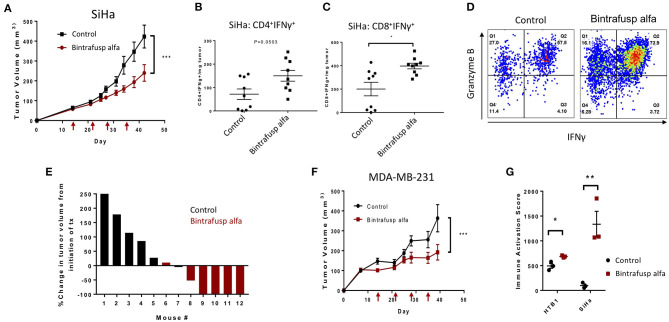
Bintrafusp alfa confers a robust anti-tumor effect in the HPV+ SiHa cervical and MDA-MB-231 triple negative breast cancer models. (A) Average SiHa tumor volumes from control (black) or bintrafusp alfa-treated (red) PBMC humanized mice (n = 21, 2-tailed ANOVA, ***p < 0.0001, data combined from 2 independent experiments). (B,C) Tumor infiltrating CD4+
(B) and CD8+
(C) IFNγ-producing T cells per milligram tumor weight at day 21 post-initiation of bintrafusp alfa treatment (n = 9, *p < 0.05, student's t-test). (D) Representative dot plots from the tumor of control (left) and bintrafusp alfa-treated (right) mice bearing SiHa tumors. IFNγ is represented on the x-axis and granzyme B on the y-axis. (E) Waterfall plot of the percent change in SiHa tumor volume from the initiation of treatment in one independent experiment at day 28 post-initiation of bintrafusp alfa treatment. (F) Average MDA-MB-231 tumor volumes from control-IgG1 (black) or bintrafusp alfa-treated (red) PBMC humanized mice (n = 9, 2-tailed ANOVA, ***p < 0.0001, data combined from 2 independent experiments). (G) Immune activation score derived from gene expression profiles (as described in Figure 6) from HTB-1 and SiHa tumors from control and bintrafusp alfa-treated mice (n = 3, *p < 0.05, **p < 0.01, student's t-test).